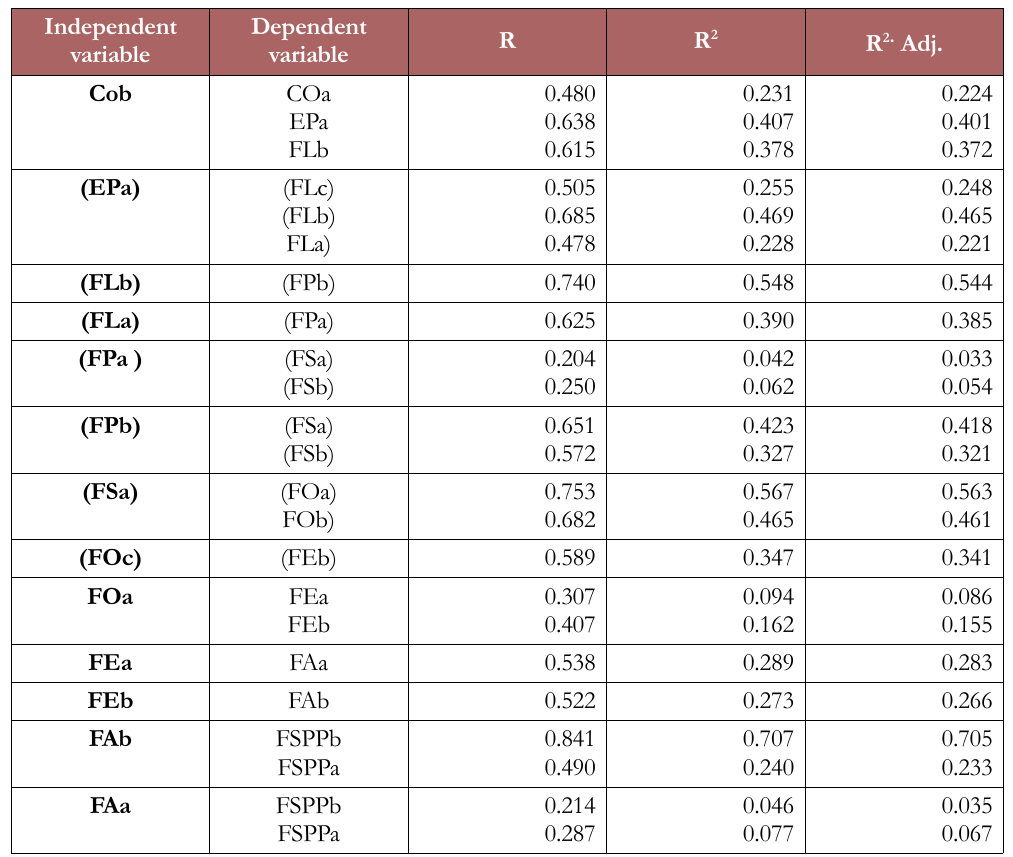
Table 22. Stepwise regression analysis with all process of